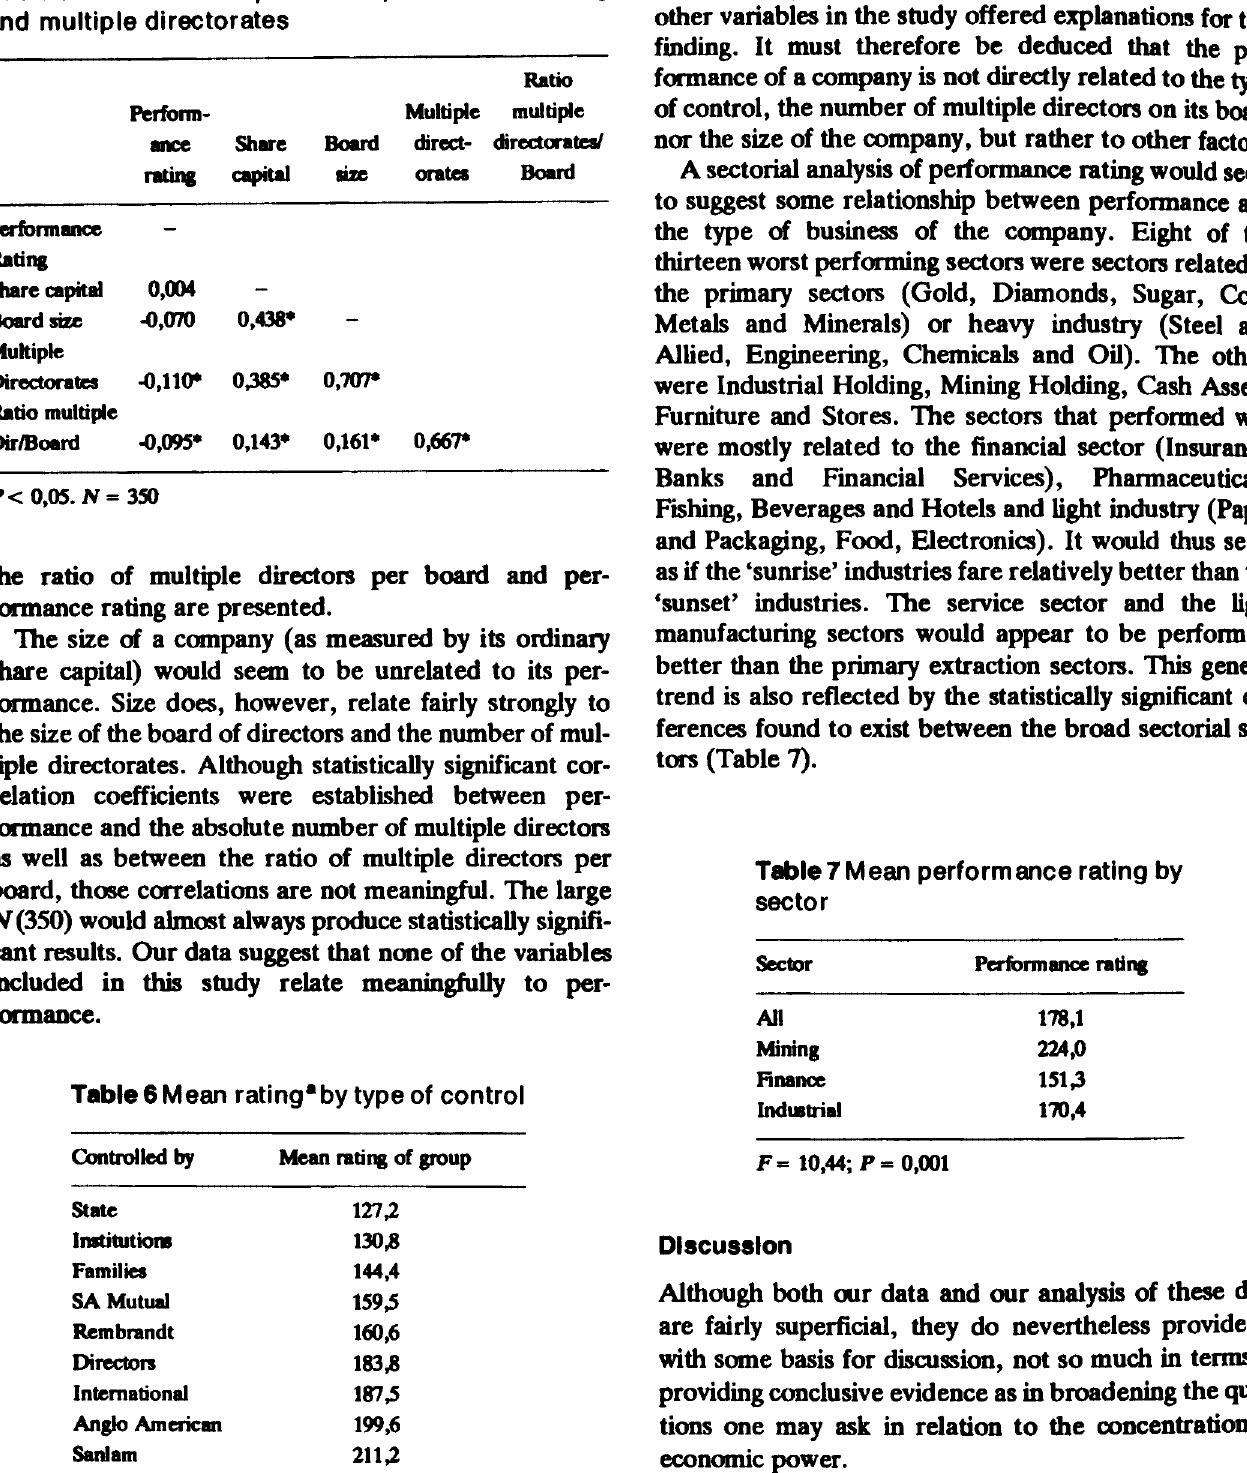
Table 5 The relationship between performance rating and multiple directorates